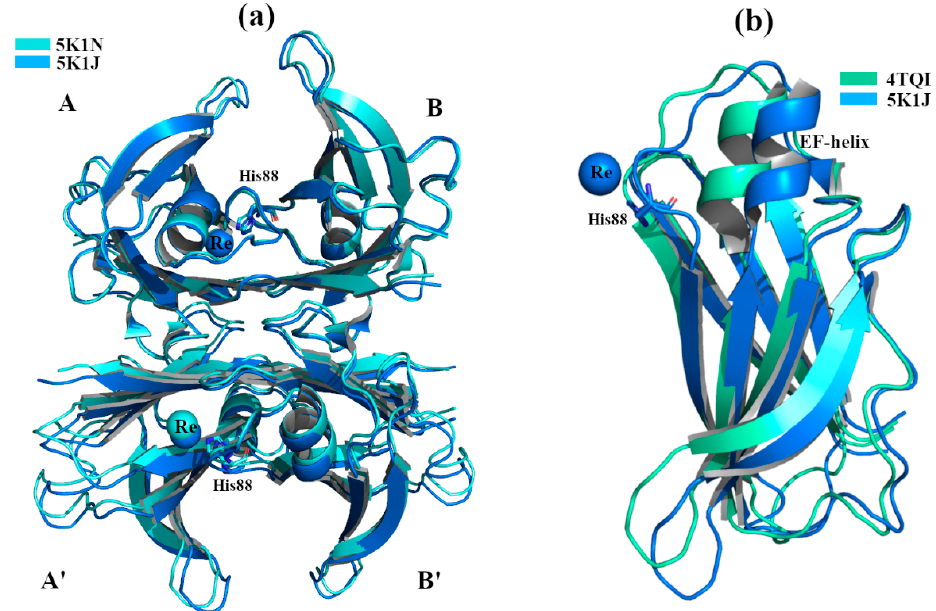
Figure 2. TTR crystal structures in complex with Re 2+ . The figure was created by author downloading the appropriate PDB codes. ( a ) Superposition between the two crystals structures soaked with Re 2+ under acidic conditions. The common Re 2+ binding site is shown. ( b ) Superposition of monomers B between the standard conformation (PDB 4TQI) versus the new one (5K1J). The major difference is visible around the EF-helix of PDB structure 5K1J that is shifted.